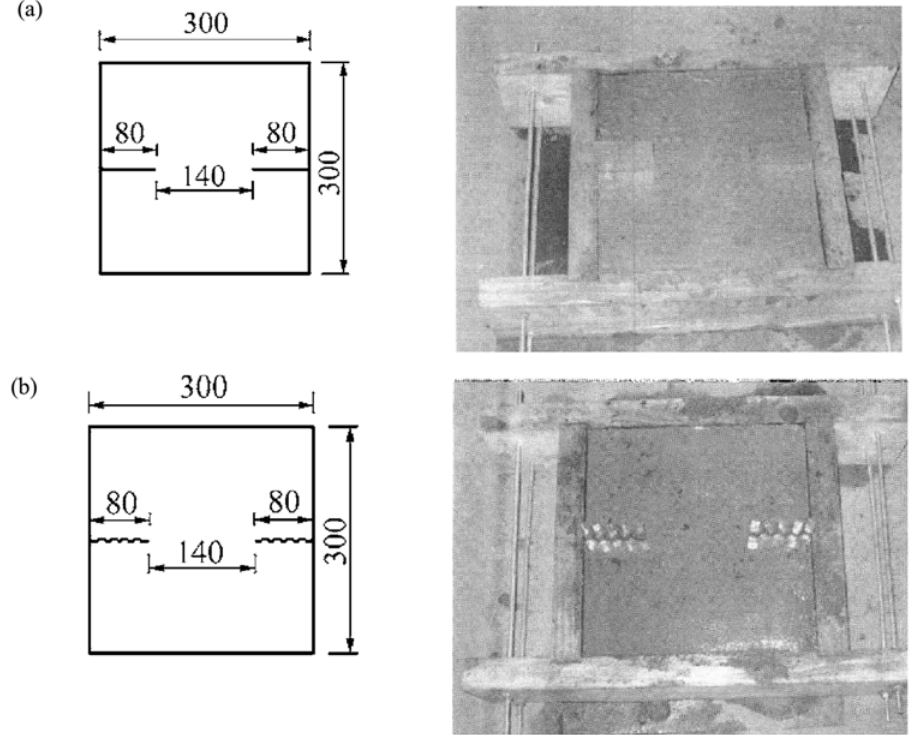
Fig 9. The rock mass samples containing joints[18] ((a)The first rock mass sample containing joints (the visual angles β 0 of joints = 0°);(b)The second rock mass sample containing joints (the visual angles β 0 of joints = 30°))